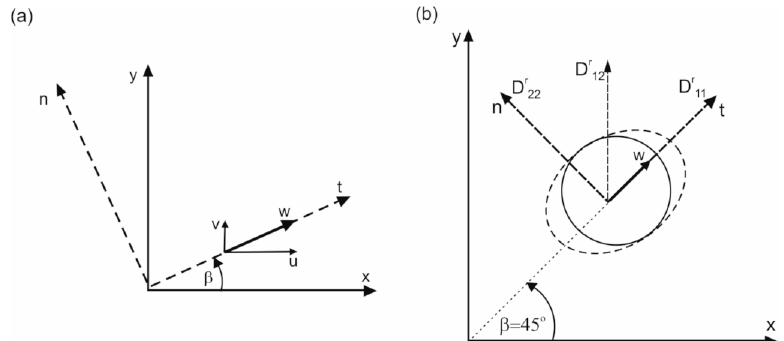
Figure 3. ( a ) Rotation of the x – y coordinate system by the angle β ( n —perpendicular direction, t —tangential direction, w —velocity vector); ( b ) components of the diffusivity tensor D r in the new system t – n oriented at the angle β = 45 o